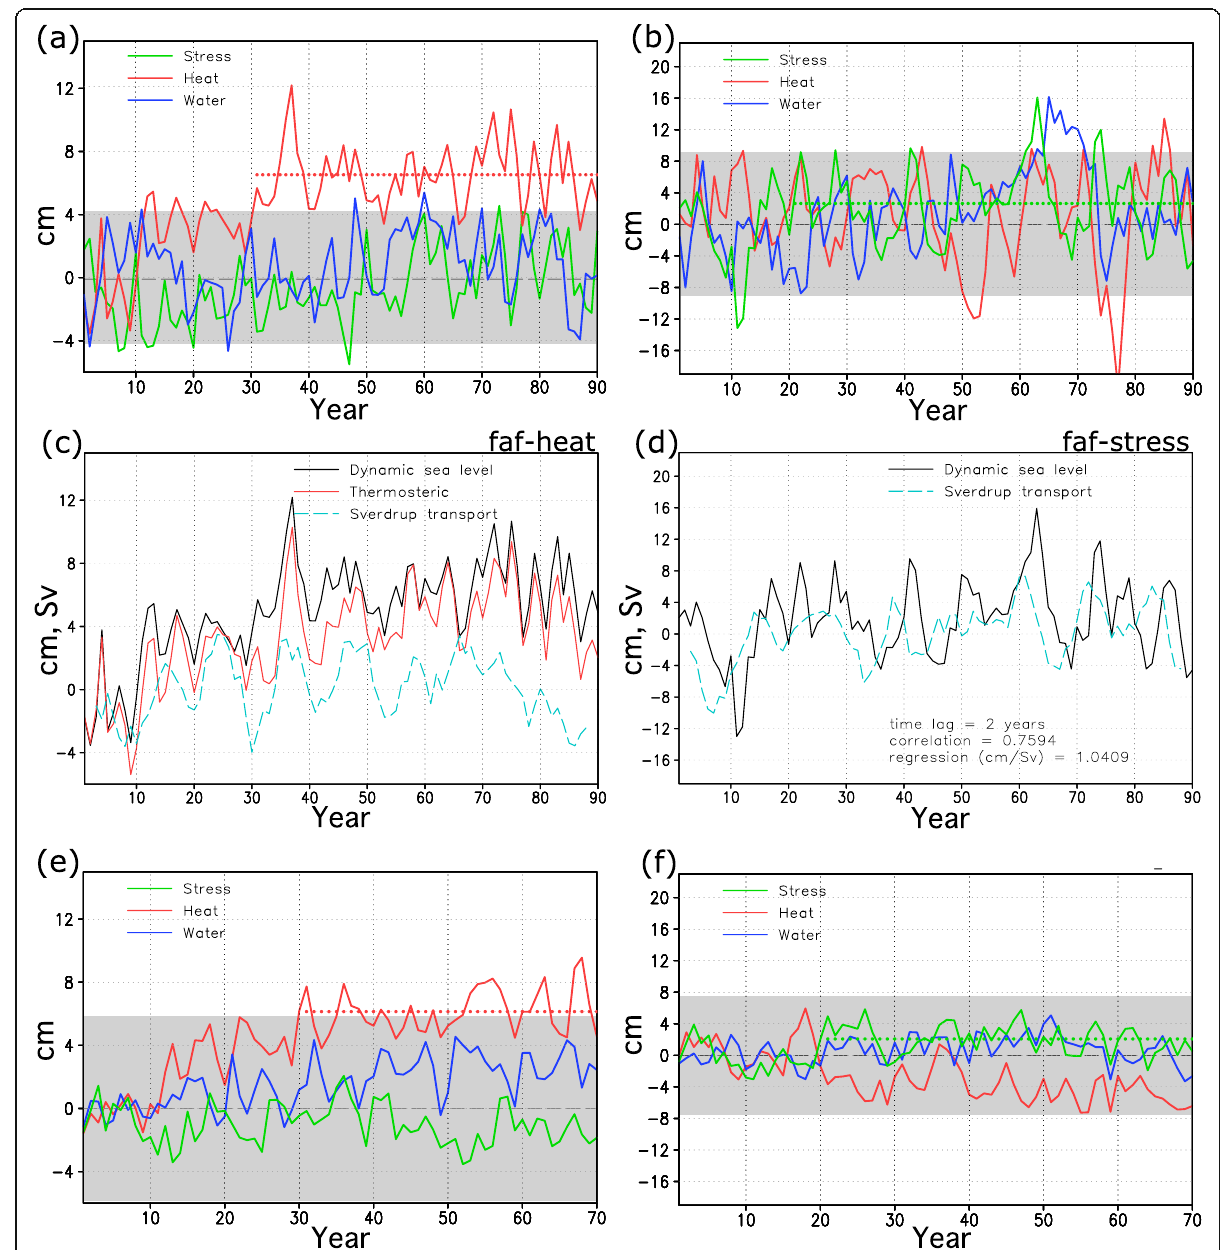
Fig. 3 Time series of DSL in a the KE recirculation (20° N – 35° N, 140° E – 160° E) and b KE (33° N – 37° N, 140° E – 150° E) for faf-stress experiment (green lines), faf-heat experiment (red lines), and faf-water experiment (blue lines). The red dotted line in a shows the time average of the faf-heat experiment between years 30 and 90 (6.5 cm). The green dotted line in b indicates the time average of the faf-stress experiment between years 20 and 90 (2.7 cm). The shaded areas in the upper panels indicate the range of piControl. c The DSL change (black line), the thermosteric sea level change (red line), and the Sverdrup transport stream function (dotted sky-blue line) in the KE recirculation for the faf-heat experiment. d The changes in the DSL (black line) and the Sverdrup transport stream function (dotted sky-blue line) in the KE for the faf-stress experiment. e , f Same as a and b , respectively, but for the ensemble mean of MIROC5.2. The red dotted line in e shows the time average of the faf-heat experiment between years 30 and 70 (6.1 cm). The green dotted line in f indicates the time average of the faf-stress experiment between years 20 and 70 (2.1